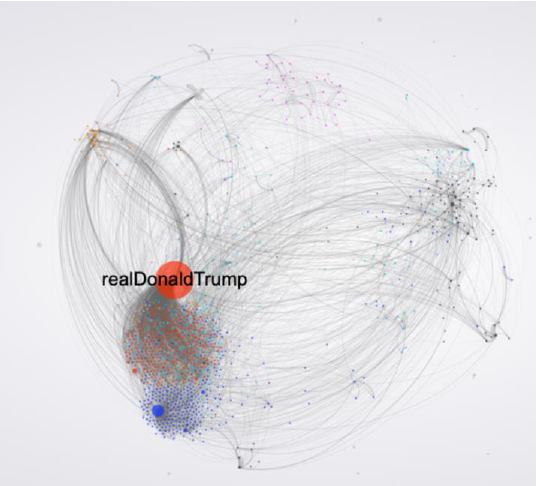
Figure 2. A social network graph by mentions of 1164 nodes (users) and 4406 directed edges (men- tions); Spatialization: OpenOrd (with Noverlap); Size: Weighted Degree; Color: Modularity Class 1